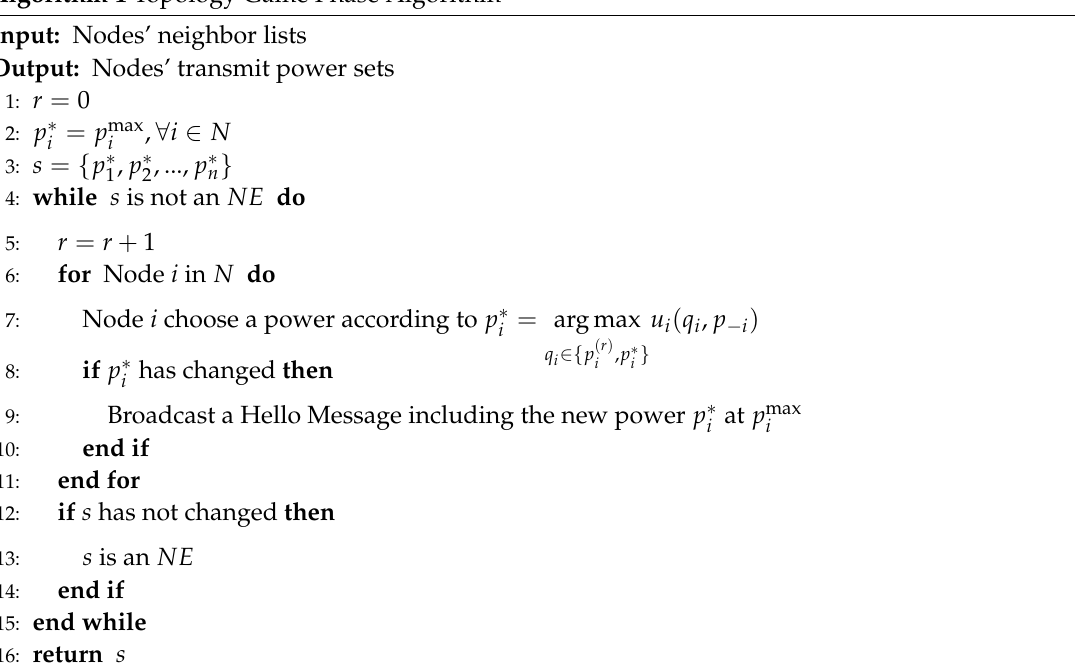
Algorithm 1 Topology Game Phase